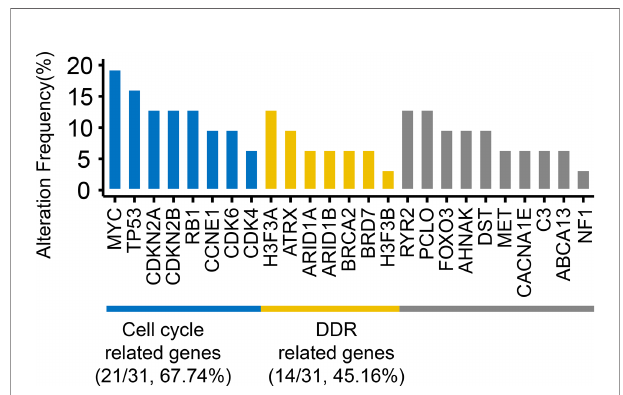
FIGURE 2 | The frequencies of top mutated genes. The genes with the mutations occurring ≥ 4 samples and reported driver genes were included. Numbers in parentheses represented the number and frequency of mutated samples.